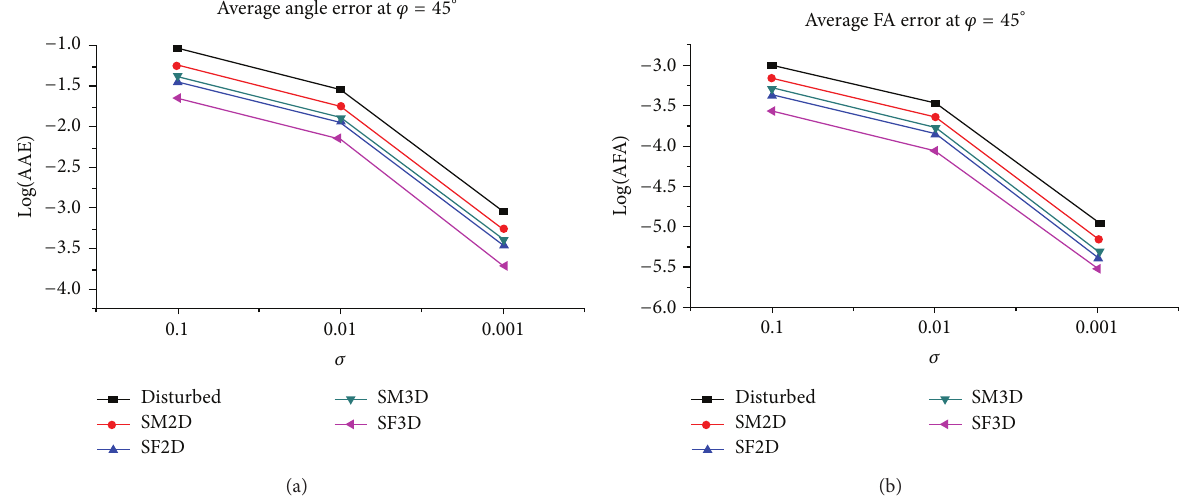
Figure 7: Errors with respect to 𝜎 = 0.1, 0.01, and 0.001 when we recover the synthetic data 𝐴 𝐼𝐼 using the four median filtering methods: (a) Log (AAE) error and (b) Log (AFA)